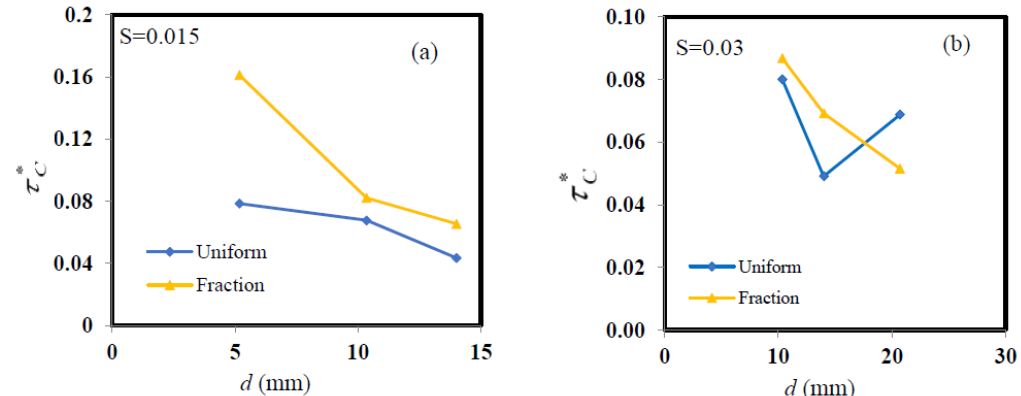
Figure 4. Critical Shields stress against of sediment diameter in bed slope of 0.015 ( a ) and 0.03 ( b ).